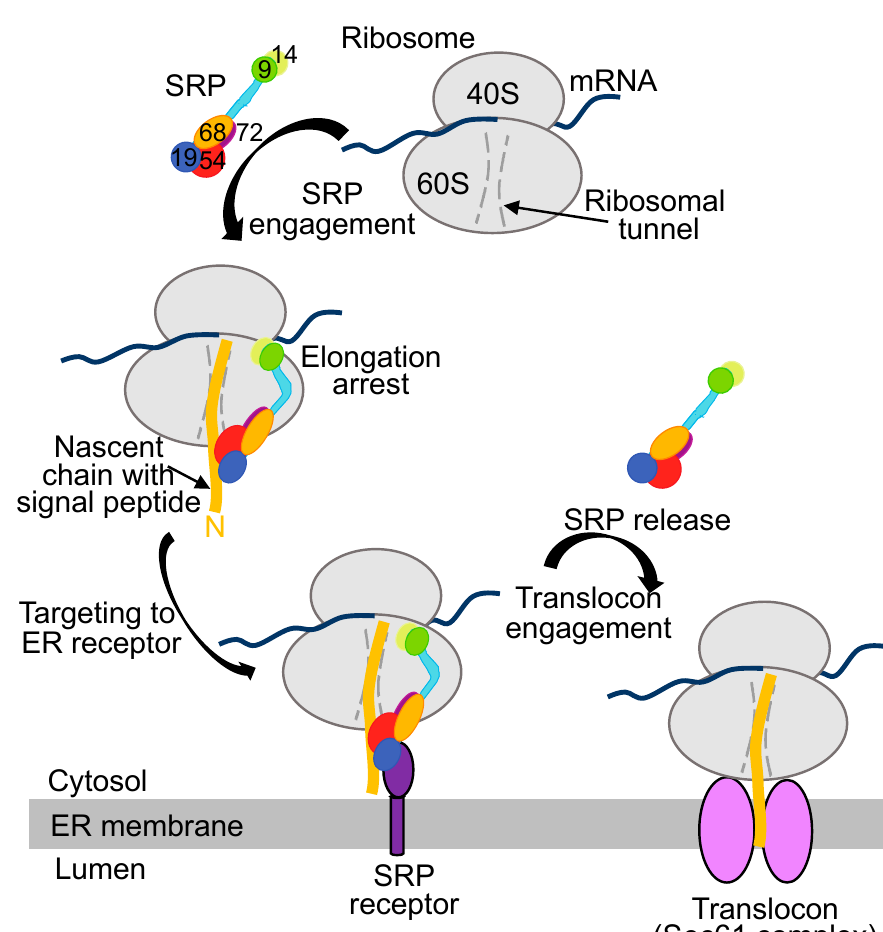
Figure 2. Signal Recognition Particle (SRP) pathway for targeting secretory proteins to the endoplasmic reticulum (ER) membrane. Signal recognition particle is a multiprotein complex composed of a non-coding RNA (7SL RNA) and six protein subunits, SRP9 (green), SRP14 (yellow), SRP68 (orange), 72 (dark purple), SRP19 (blue) and SRP54 (red). All protein subunits are assembled on the about 300 nucleotide long 7SL RNA (light blue). When a secretory protein is being synthesized on ribosome, SRP recognizes its N-terminal signal peptide, binds it, temporary stops translation and targets the whole ribosome-nascent chain complex (RNC) to the ER membrane. SRP receptor located in the ER membrane binds SRP-RNC complex. Interactions with the receptor triggers engagement of Sec61 translocon with consequent release of the targeting factor (SRP). Nascent chain now is co-translationally translocated in the ER lumen where processing and modifications of new protein occur.